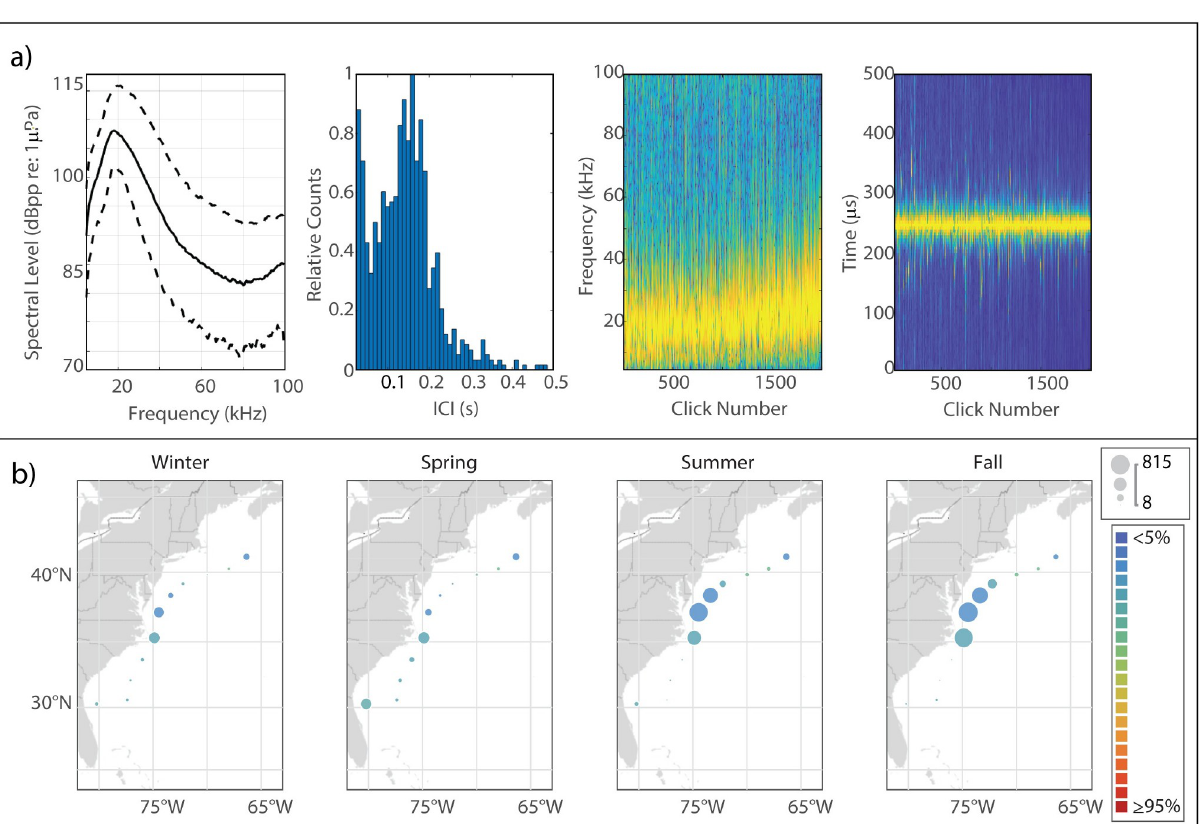
Fig 14. Results for UD19 showing click type (a), and acoustic presence (b). Subplots as in Fig 2a and